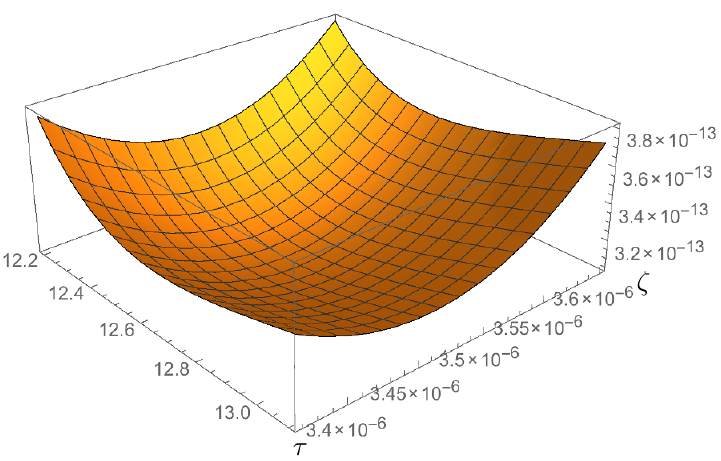
Figure 6 . Left: V ( (cid:16); (cid:28) ) for (cid:28) = 12 : 59, Right: V ( (cid:16); (cid:28) ) for (cid:16) = 3 : 47 (cid:1) 10 (cid:0) 6 , both cases for (cid:27) = 0, (cid:18) = (cid:0) (cid:25)= 2 and the choice of parameters: M = 70, K = 70, g s = 1 = 2, A = a = 1.